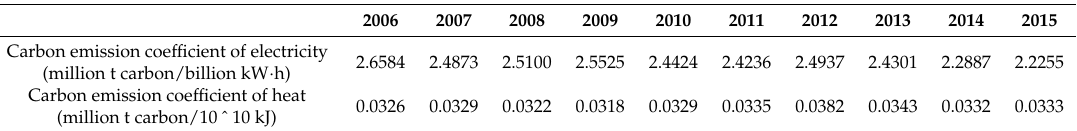
Table 3. Carbon emission coefficients of electricity and